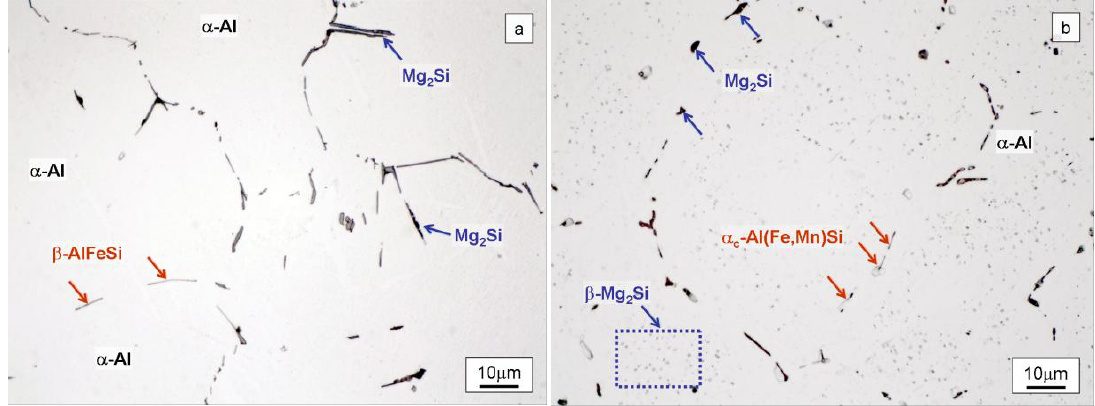
Figure 3. Light optical microscopy (LOM) microstructure of the billet in the intermediate zone after etching with 0.5% HF aqueous solution ( a ) in the as-cast billet it is possible to observe β-AlFeSi plate-like particles (light grey) and Mg Si coarse particles originate from 2 non equilibrium solidification both located at grain boundary and ( b ) after homogenization treatment β-AlFeSi needles transforms into α-AlFeSi discontinuous fragments in grain boundary (light grey) and Mg Si particles transform into round particles 2